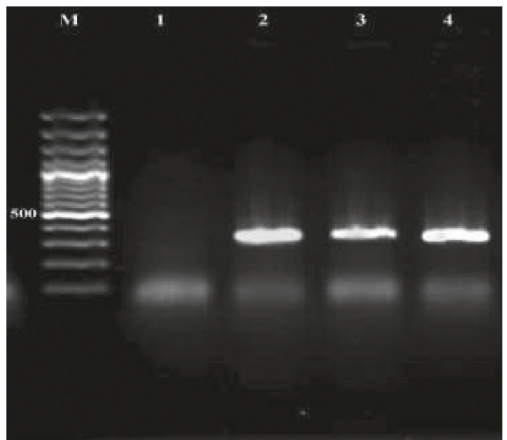
Figure 9: PCR product electrophoresis of 392bp phzI gene (from left, lane M: marker 100bp, lane 1: negative control, and lanes 2–4: positive samples).